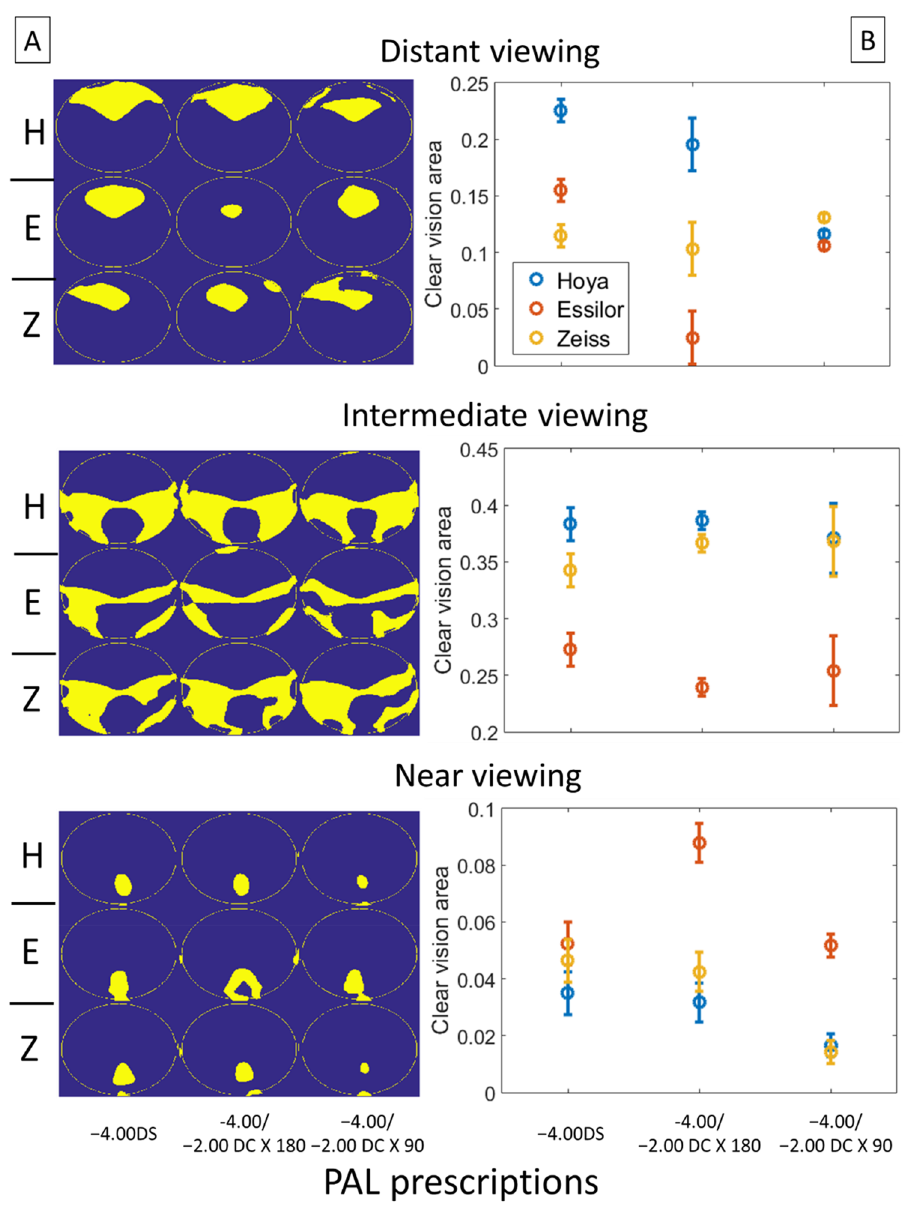
Figure 11. Area of clear vision of different PALs for near, intermediate, and far distance metric (cid:31) L . ( A ) Binary image showing area of clear vision (yellow) and area with (cid:31) L more than ± 0.25D from the target prescription (blue). The calculations in each plot were based on data of four lenses with the same prescription. H Hoya, E Essilor, Z Zeiss. ( B ) Proportion of clear vision area as a function of PAL prescription. The proportion was calculated as area of clear vision to the total area of measurement. Error bars represent standard